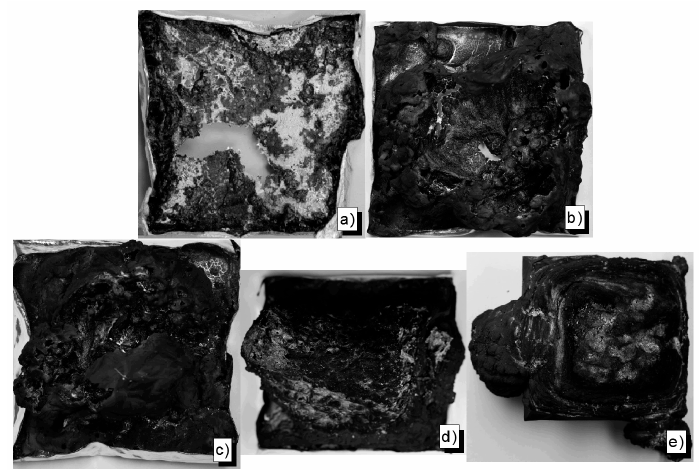
Figure 12. Residue pictures: EP ( a ); EP-15-ExOP935 ( b ); EP-15-ExOP1230 ( c ); EP-15-ExRP ( d ); and EP-25-BDP ( e ).